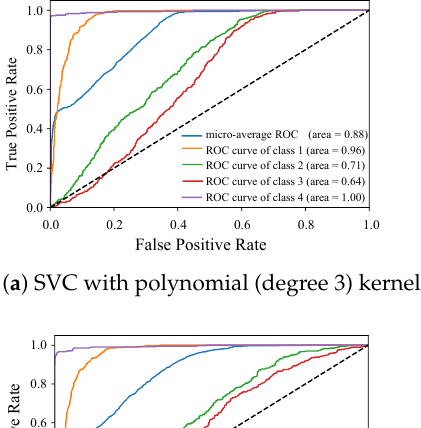
micro-average ROC (area = 0.88) ROC curve of class 1 (area = 0.96) ROC curve of class 2 (area = 0.71) ROC curve of class 3 (area = 0.64) ROC curve of class 4 (area = 1.00)